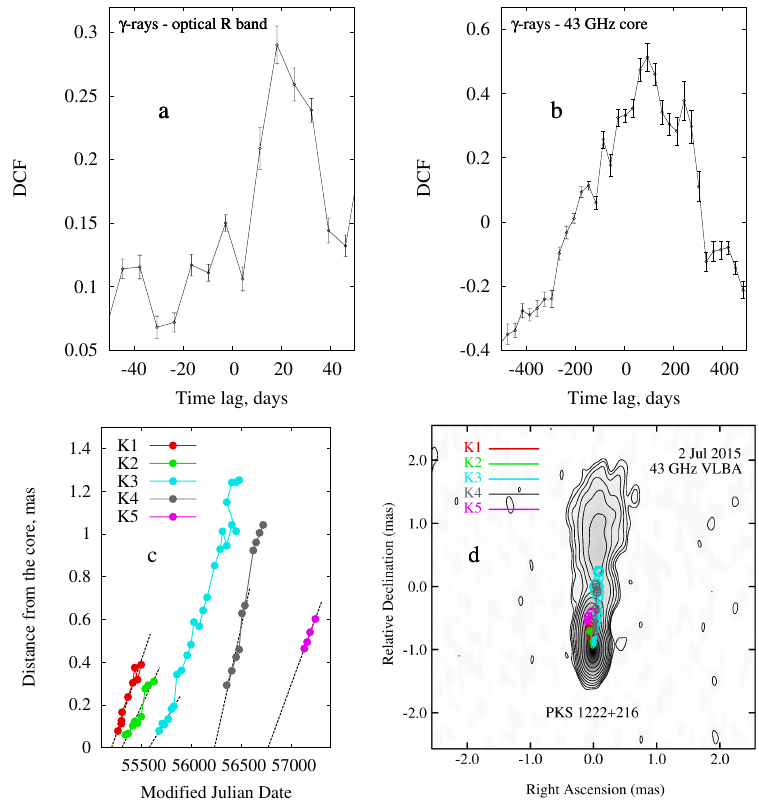
Figure 3. ( a ) Discrete correlation function (DCF) between the γ -ray and optical R-band data (7-day binning); ( b ) Discrete correlation function between the γ -ray and 43 GHz VLBI core data (30-day binning); ( c ) Distance from the 43 GHz VLBI core vs. time for knots K1–K5 (dashed lines represent linear extrapolation to zero distance from the core); ( d ) VLBA images at 43 GHz with overlaid trajectories of knots